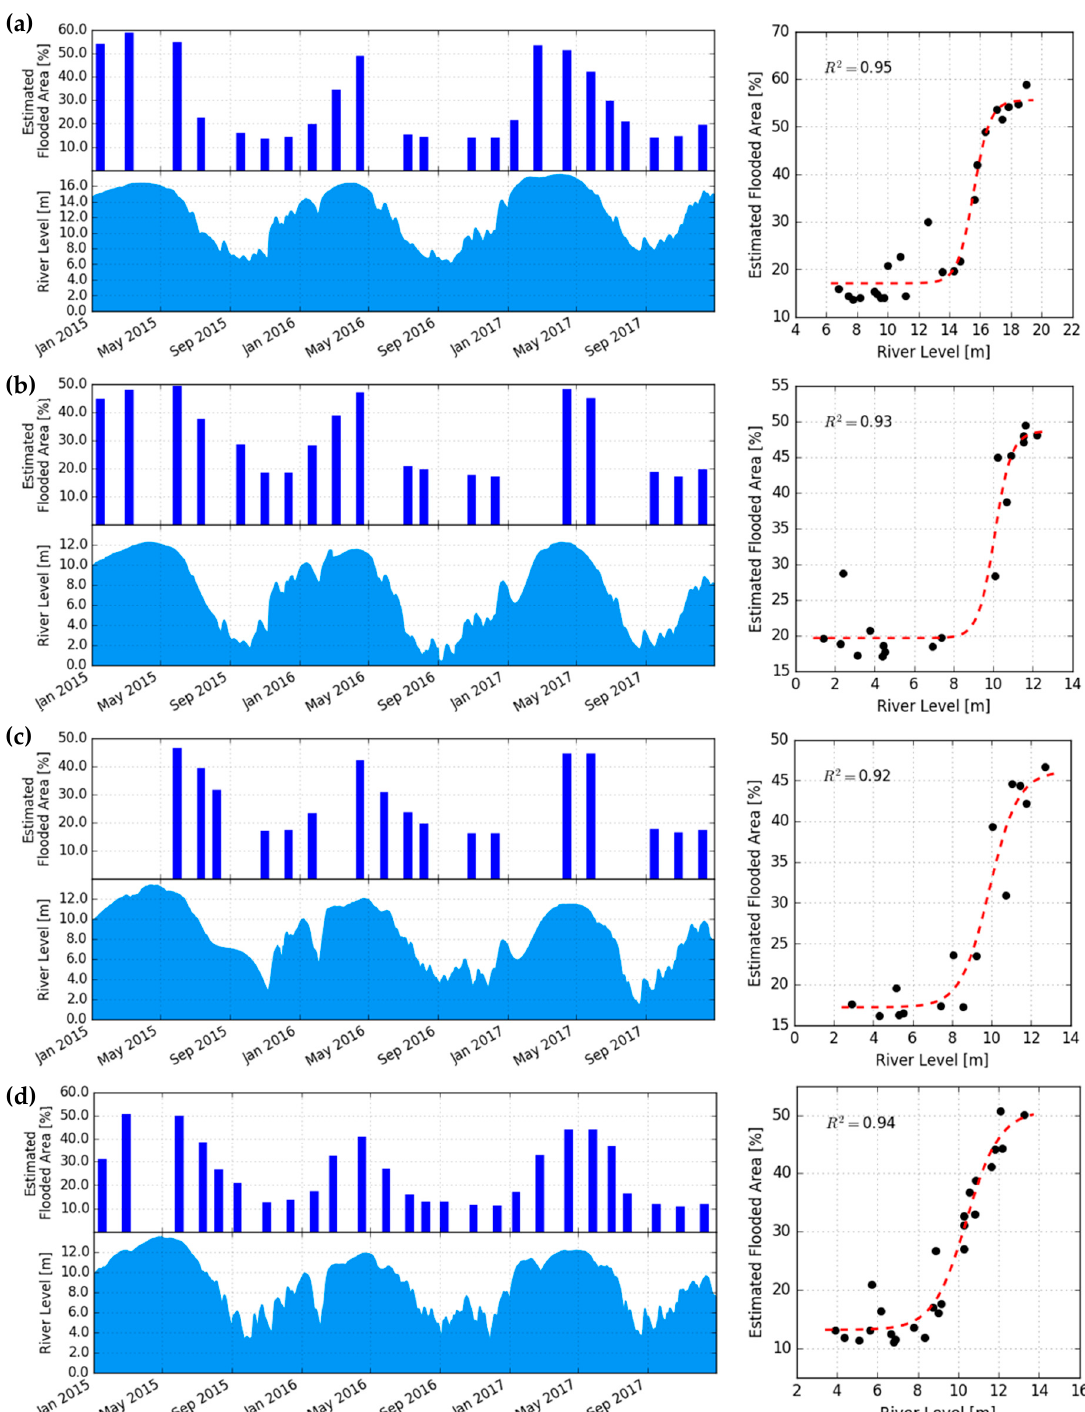
Figure 10. Time series of PALSAR-2 classified flooded area percentage (open water, inundated non-forest and inundated forest) in the surrounding area within a 5 km radius and river level measurements (left) and scatter plots of corresponding values fitted to a logistic model (right) of the four field stations with locations shown in Figure 1: ( a ) Flor de Punga, ( b ) Requena, ( c ) Nauta, ( d ) San Regis.